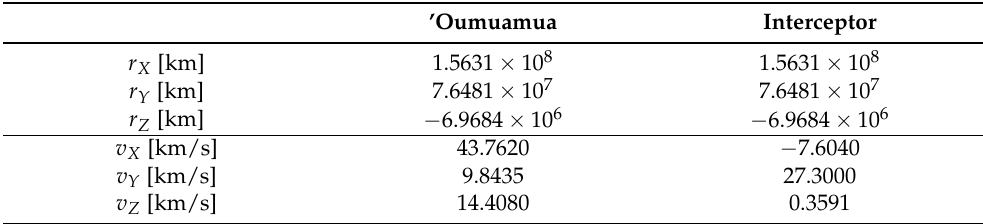
Table 4. State vectors, in km and km/s, of ’Oumuamua and interceptor on 16 October 2017 at 23:30 TDB.